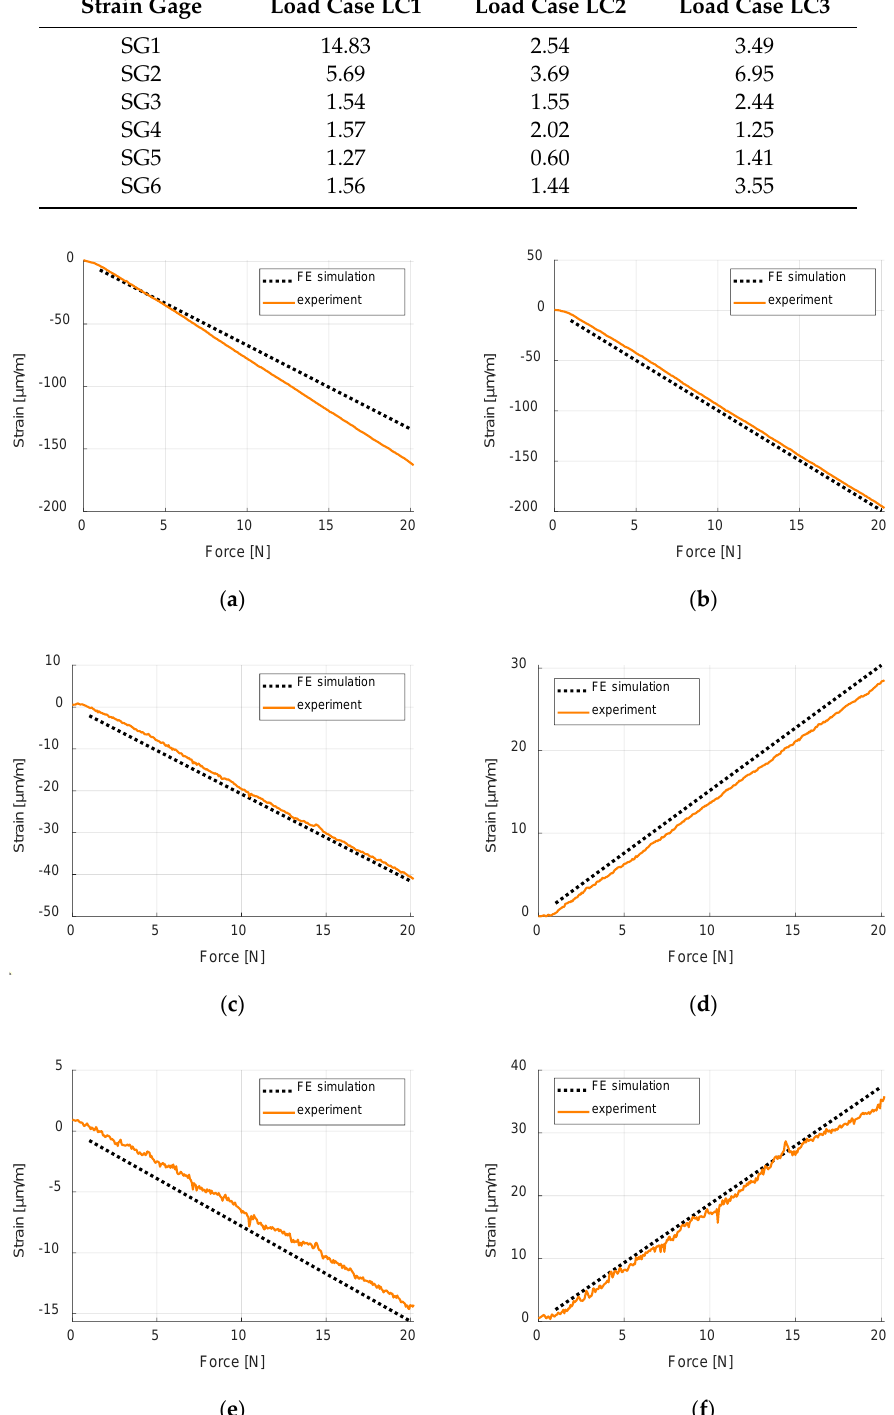
Figure 9. Comparison of numerical and experimental strain vales during load lase LC1: ( a ) strain gauge SG1; ( b ) strain gauge SG2; ( c ) strain gauge SG3; ( d ) strain gauge SG4; ( e ) strain gauge SG5; and ( f ) strain gauge SG6.